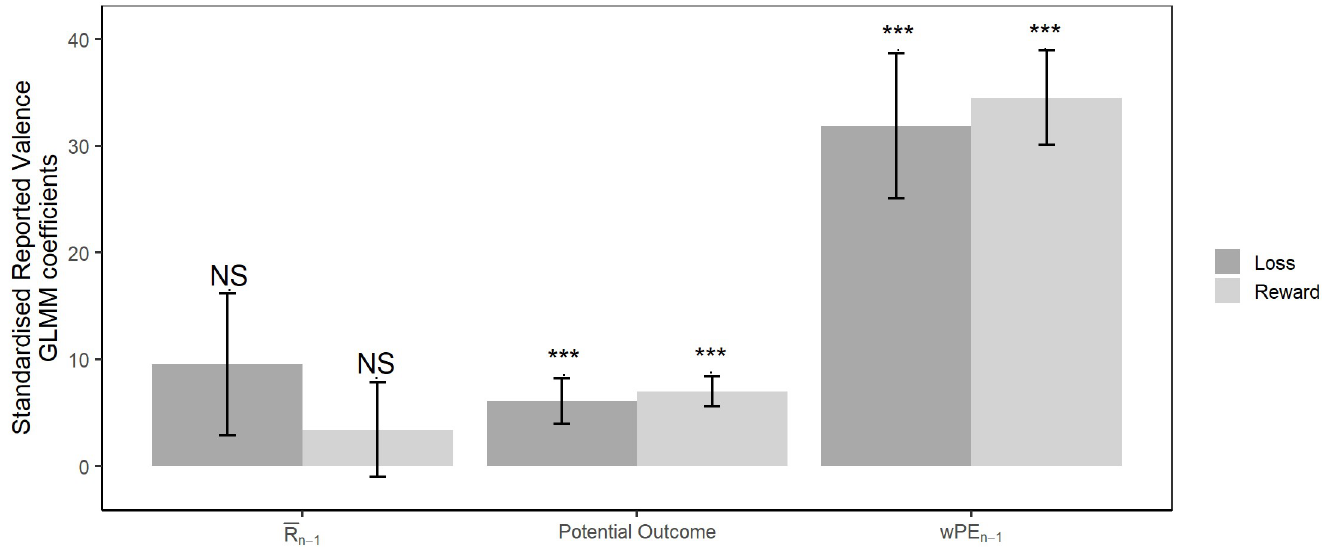
Fig 3. Valence GLMM coefficients. Standardised GLMM coefficients from the model of the reported affective valence for both the fluctuating reward and fluctuating loss condition. Positive values for the standardised GLMM coefficients reflect a positive relationship between reported valence and the predictor variable, while negative values reflect a negative relationship. Error bars represent one standard